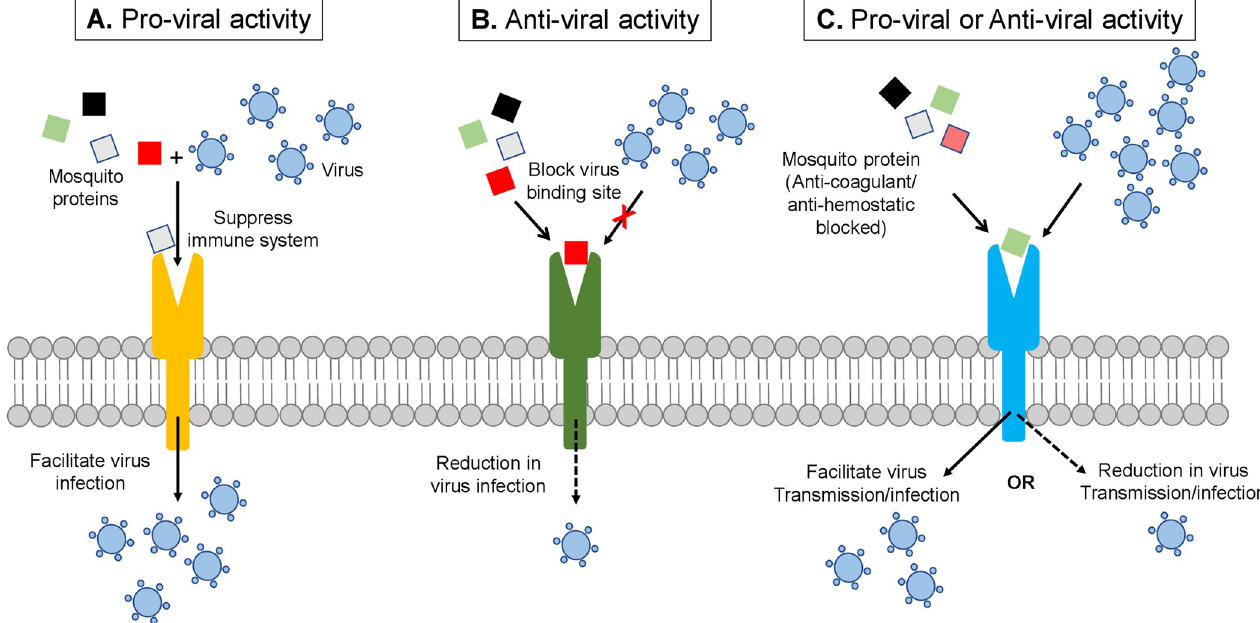
Fig 5. Schematics of the potential role of SGPs interactions with human host receptor proteins on pathogen transmission and or infection. ( A ) SGP binds to human immune receptor proteins resulting in host immunosuppression, thereby, promoting viral infection and replication. ( B ) SGP binds to human receptor protein and blocks the binding site of invading pathogens on the receptor resulting in the abrogation of pathogen cellular entry and reduced overall infection. ( C ) Anticoagulant SGP or proteins with anti-hemostatic activities hijacked by human receptor making it possible for blood to clot easily at the bite site resulting in the difficult acquisition of blood by feeding mosquitoes. This may cause the mosquito to inject more pathogen-infected saliva which could lead to enhanced pathogen transmission. Conversely, excessive blood clot could deter mosquito from further feeding resulting in a lower deposition of pathogens and lower transmission or